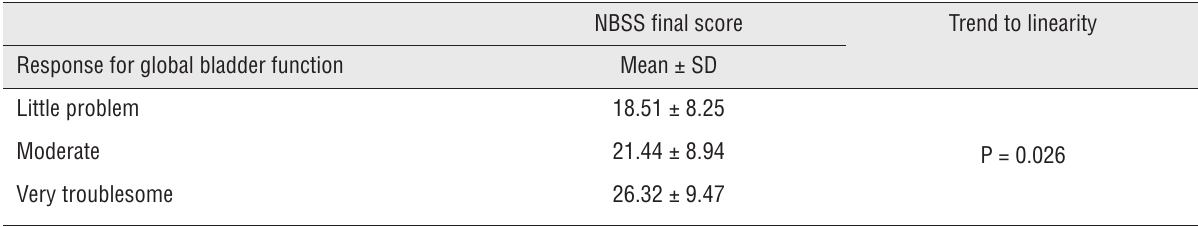
Table 3 - Variation between the final score and the severity of the voiding symptoms